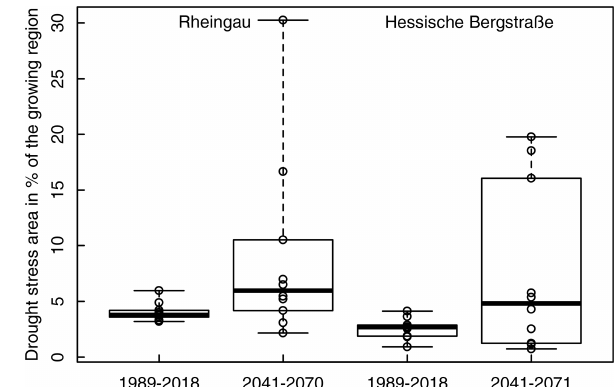
Figure 10. Potential drought stress area of two wine-growing re- gions (Rheingau and Hessische Bergstraße) in Germany for two time periods (1989–2018 and 2041–2070), calculated with a wa- ter balance model, soil maps, and 10 climate simulations with dif- ferent models for the emission scenario RCP8.5. A vineyard plot was allocated to the drought-stress-affected area if on average 10 or more days with drought stress during the vegetation period (1 May– 30 September) were calculated. Individual model results are shown as points in the